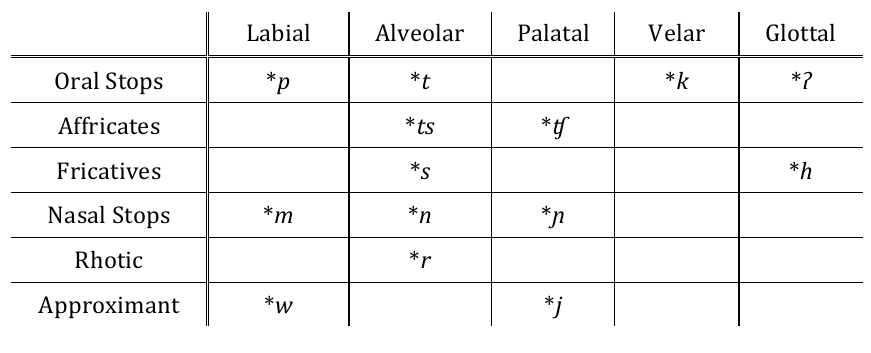
Table 1. Proto-Mojeño consonants